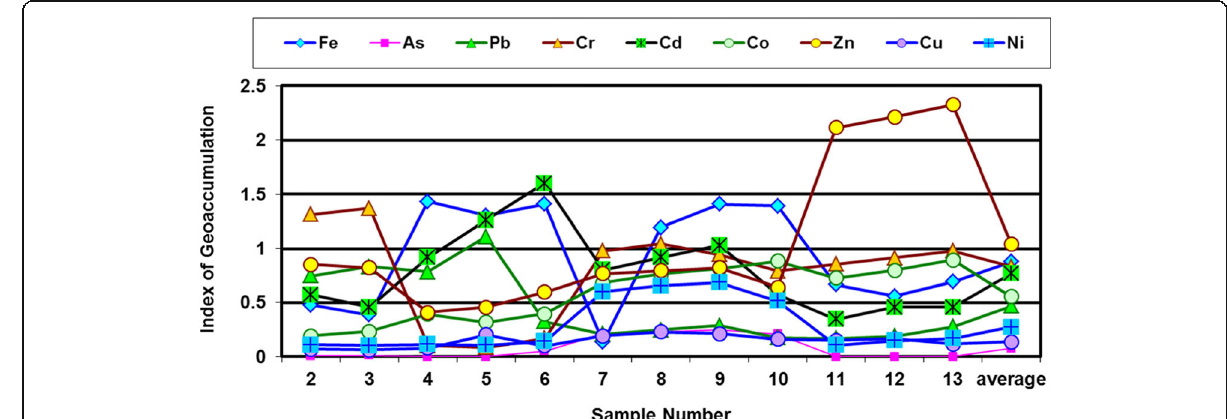
Fig. 3 Index of Geoaccumulation (I geo ) of the heavy metals of the studied samples